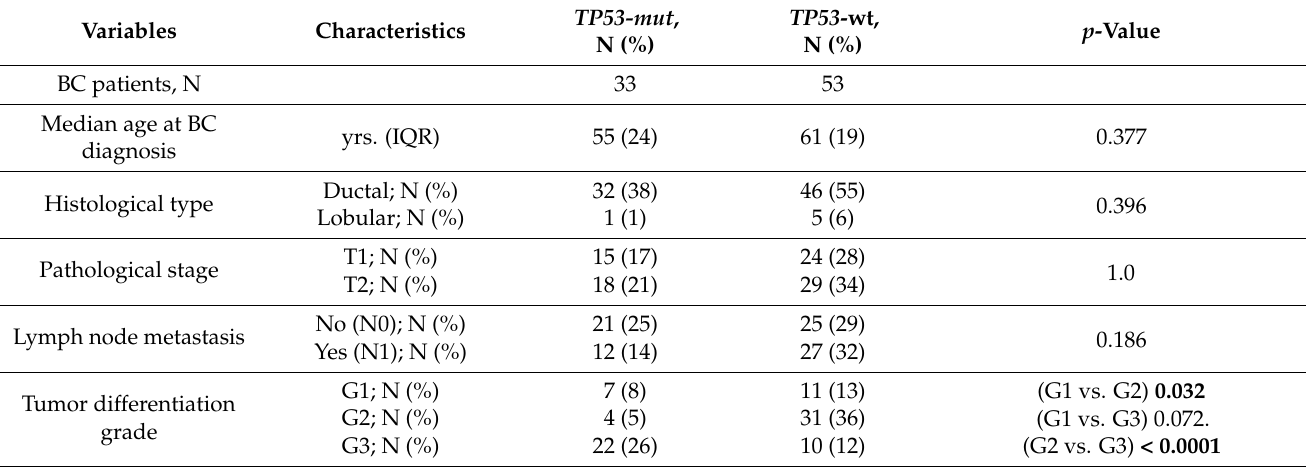
Table 1. Clinical parameters of TP53 mutation-positive ( TP53-mut ) and negative ( TP53-wt ) BC